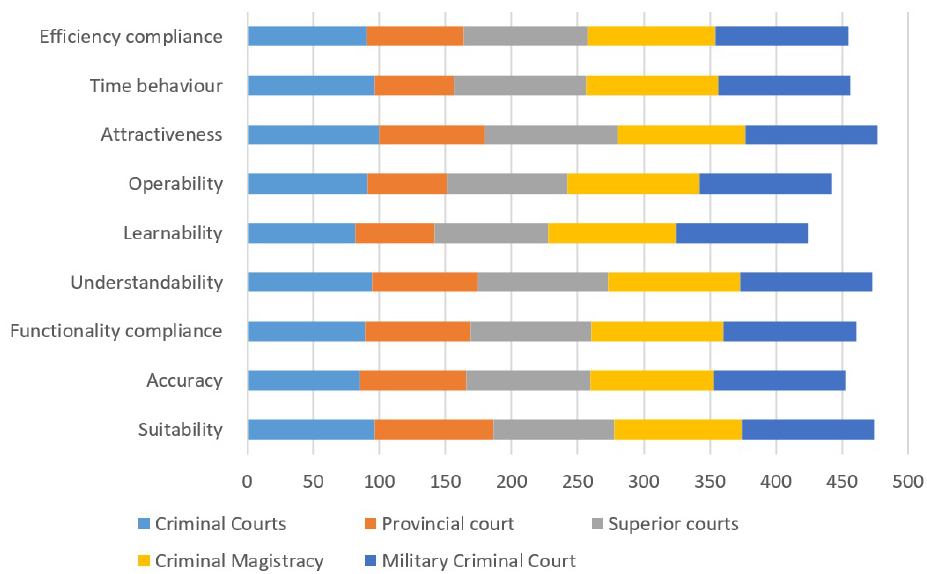
Figure 20. Grouping by design parameters